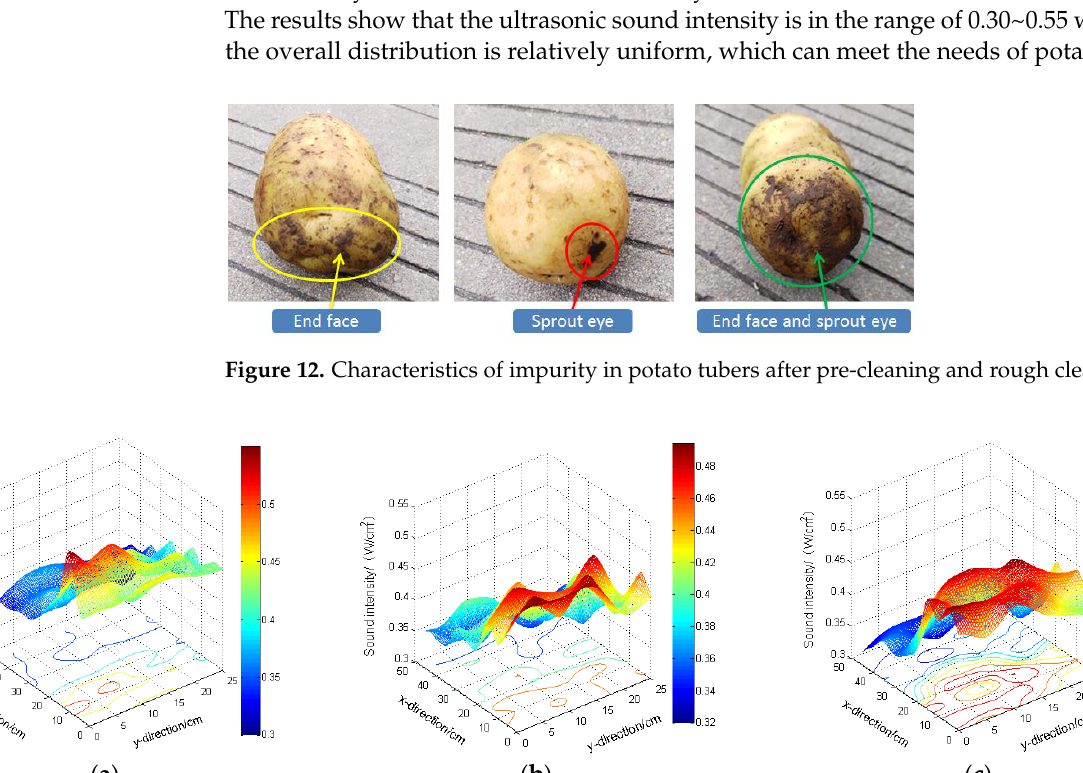
( f ) Figure 14. The gradient cleaning process of potato. ( a ) Dry-cleaning; ( b ) Pre-cleaning; ( c ) Rough cleaning; ( d ) Fine cleaning of ultrasonic; ( e ) Fine cleaning of bubble; ( f ) Cleaning effect.